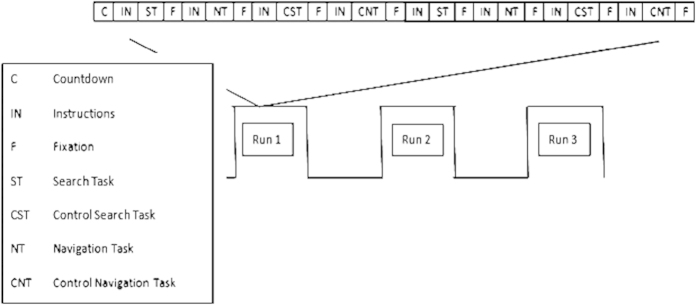
Illustration of experiment design.